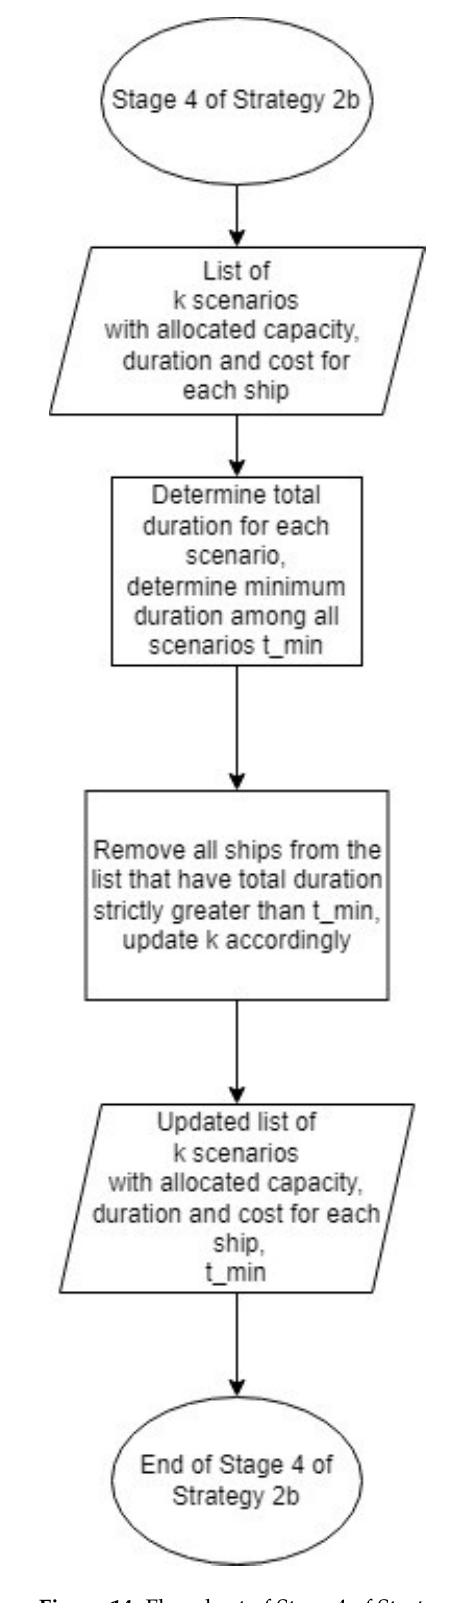
Figure 14. Flowchart of Stage 4 of Strategy 2b.